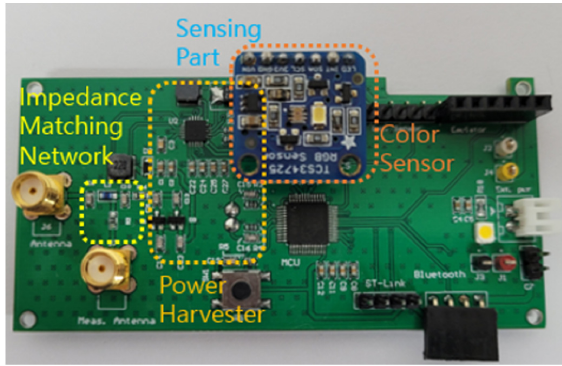
Figure 8. Smart sensor tag using RF scavenging power.